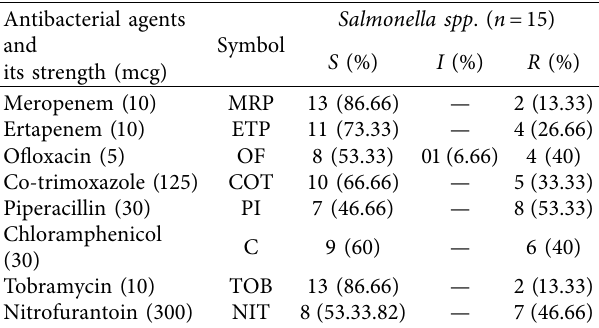
Table 2: Antimicrobial susceptibility profles of Salmonella spp . at the Wolaita Sodo University wastewater treatment plant. Antibacterial agents